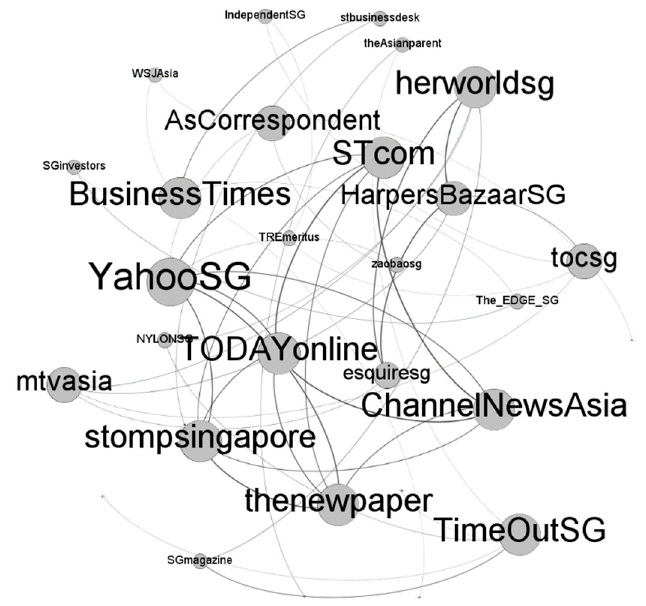
Figure 6. News media networks in Singapore (V singapore = 30, E singapore = 46). Nodes represent online news media outlets and edges represent shared followers between any two outlets. The size and the label of a node is proportional to the degree centrality of the node